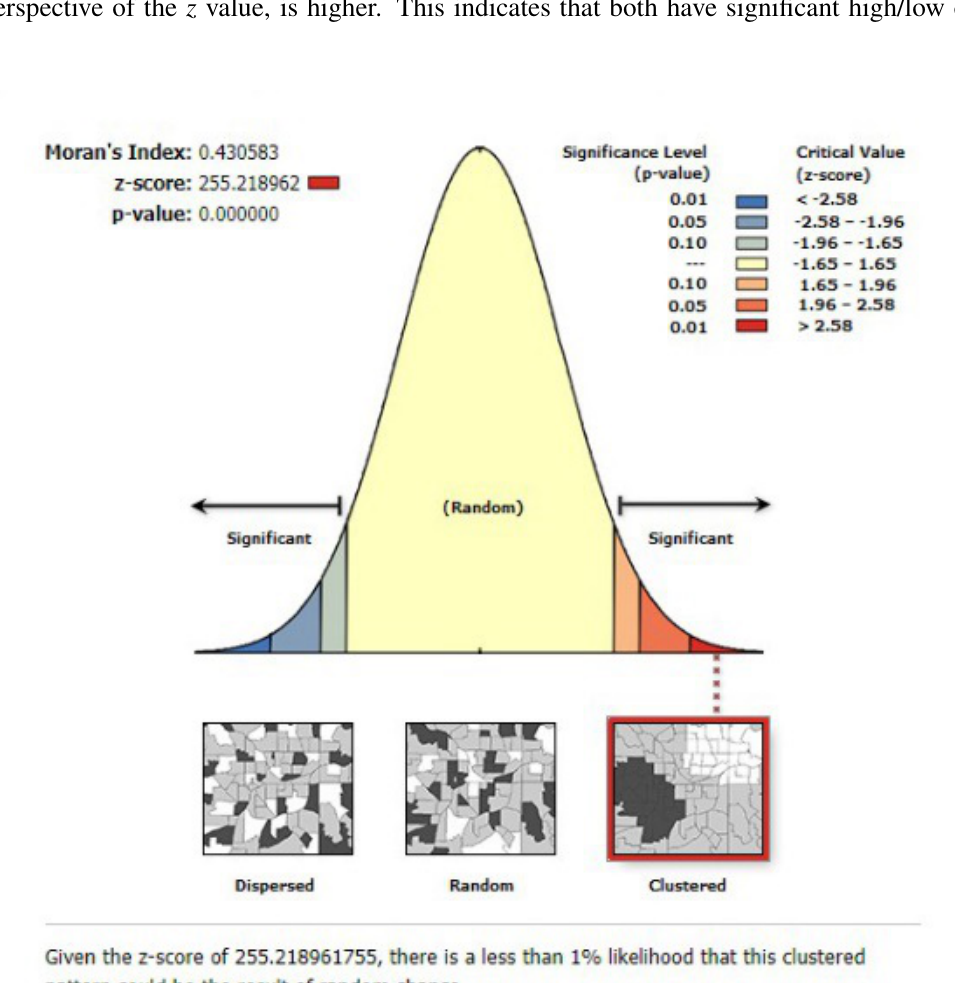
Fig. 27 Spatial autocorrelation report of